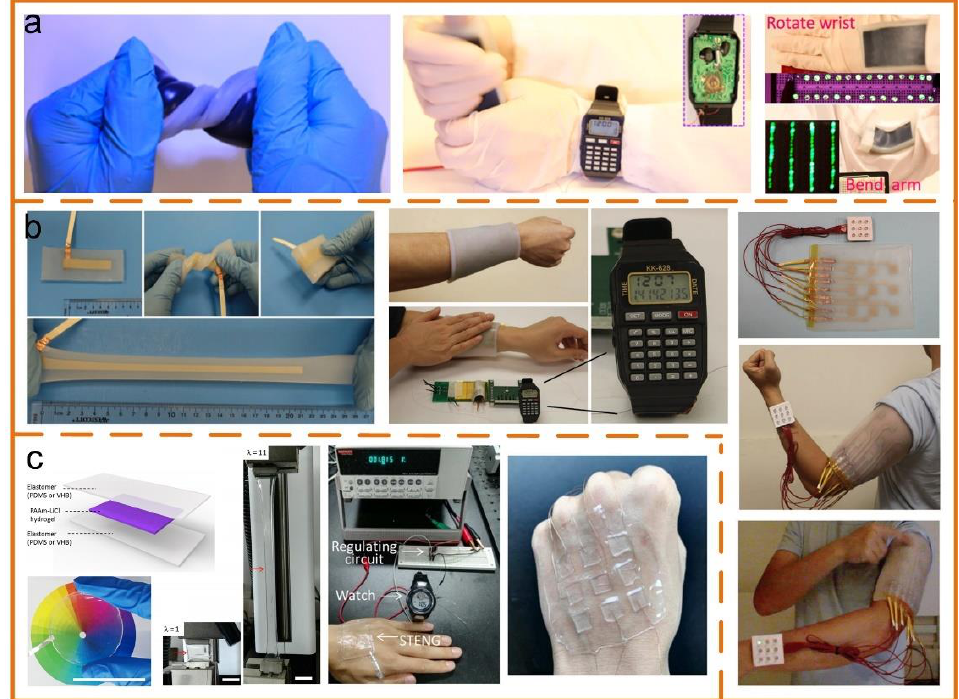
Figure 10. Self-powered sensors based on flexible and stretchable TENGs. ( a ) A stretchable and waterproof TENG based on carbon black electrode. Reproduced with permission [118]. Copyright